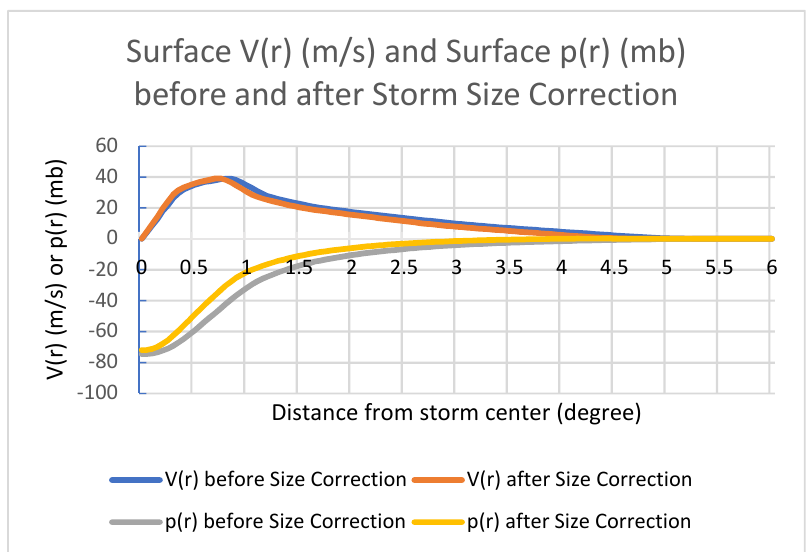
Figure 1. Impacts of the storm size correction. The storm size is reduced by ~10%. V ( r ) is the azimuthally averaged storm surface tangential wind speed (m/s), p ( r ) is the azimuthally-averaged storm MSLP perturbation (mb). The blue line and the orange line are the V ( r ) before and after the size correction, respectively. The gray line and the yellow line are p ( r ) before and after the size correction, respectively.